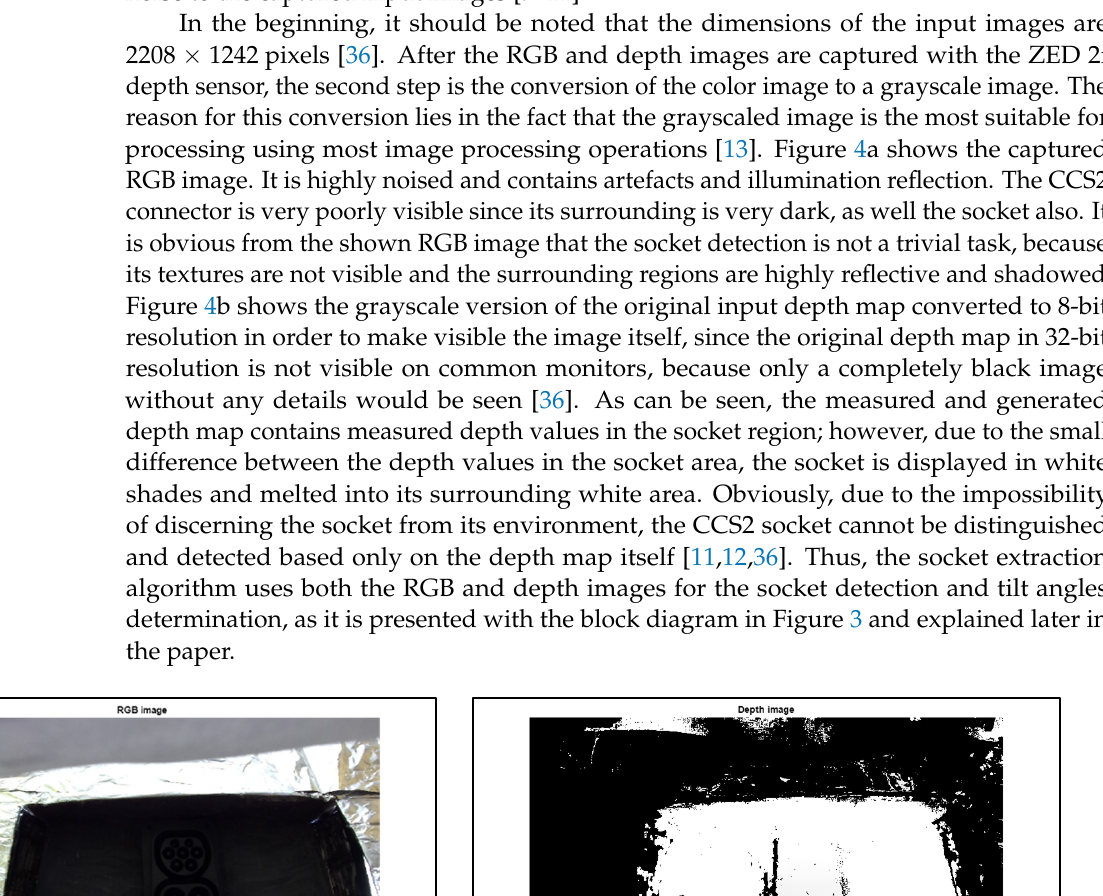
Figure 3. Block diagram of the proposed algorithm.